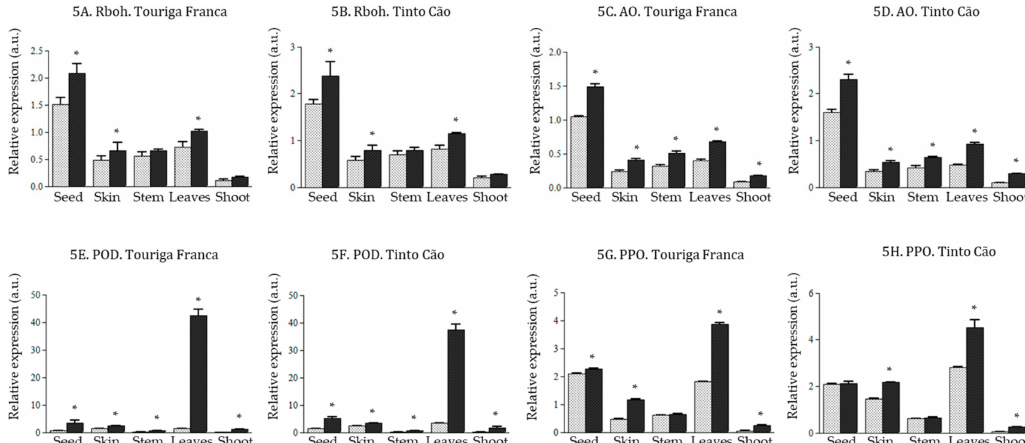
Figure 5. E ff ect of chitosan on Rboh (respiratory burst oxidase), AO (amine oxidase), POD (peroxidase), and PPO (polyphenol oxidase) genes in the tissues of grapevine ( A ). relative expression of Rboh gene in Touriga Franca, ( B ). relative expression of Rboh gene in Tinto C ã o, ( C ). relative expression of AO gene in Touriga Franca, ( D ). relative expression of AO gene in Tinto C ã o, ( E ). relative expression of POD gene in Touriga Franca, ( F ). relative expression of POD gene in Tinto C ã o, ( G ). relative expression of PPO gene in Touriga Franca, ( H ). relative expression of PPO gene in Tinto C ã o). Tissues were collected at complete maturation of the berries. Gray column = control samples; black column = chitosan-treated samples. All data were obtained from three biological replicates; standard deviations and the levels of significance ( p < 0.05; t -test) are represented by error bars and asterisks above the columns,